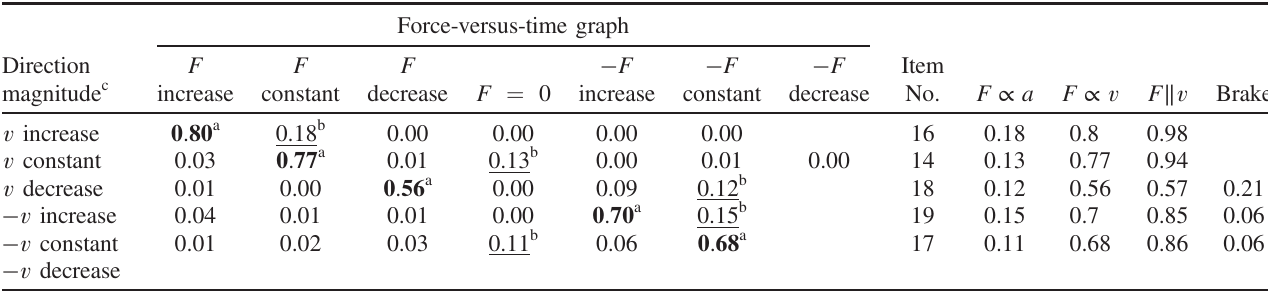
a The corresponding proportions of the F ∝ v model are shown in Table VII in bold type. b The corresponding proportions of the F ∝ a model are shown in Table VII in underlined type. c The direction and magnitude column, “ v ” represents the direction of motion to the right, and “ − v ” to the